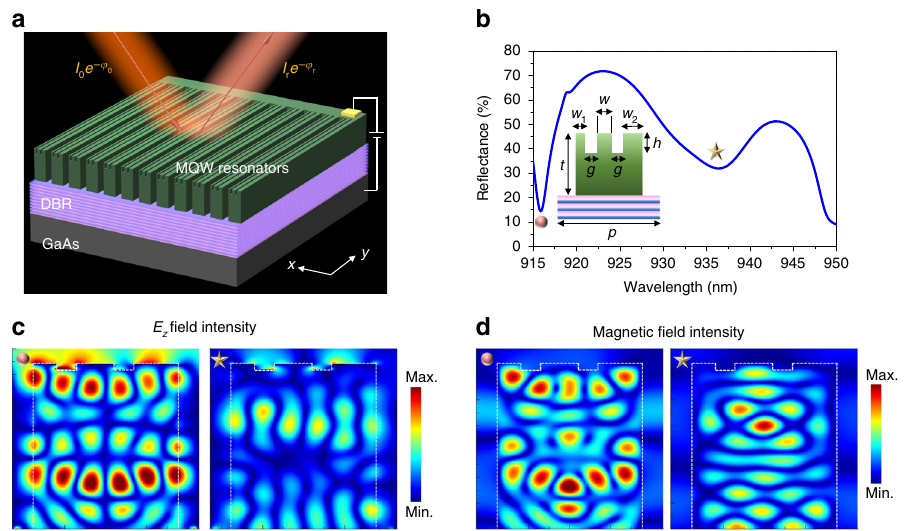
Min. Min. Fig. 2 Resonant modes in MQW-based metasurface. a Schematic for all-dielectric MQW metasurface. The metasurface consists of a n-doped GaAs substrate, a distributed Bragg re fl ector (DBR), and a 1230-nm-thick MQW layer. There is a 50-nm-thick p-doped GaAs layer with doping level of 10 19 cm − 3 that is grown on top of the MQWs as a top contact. b Simulated re fl ectance spectrum of a Mie-GM resonant metasurface under an x -polarized normal illumination. The inset shows the schematic of the metasurface unit element. The unit element dimensions are de fi ned as follows: w 1 = 110 nm, w 2 = 210 nm, w = 180 nm, g = 100 nm, t = 1230 nm, and h = 40 nm. The periodicity p is 910 nm. c , d show the spatial distributions of the E z and magnetic fi eld intensities at the wavelengths corresponding to the resonant